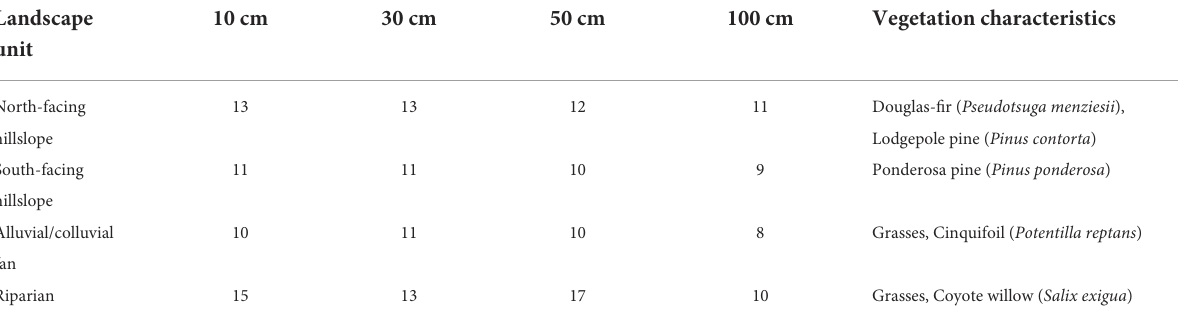
TABLE 1 Vegetation characteristics at each landscape unit and number of samples at each landscape unit and